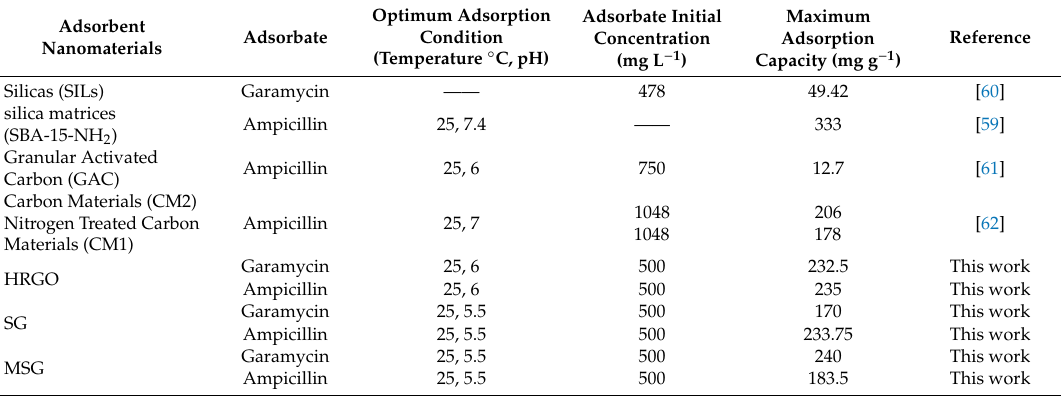
Table 2. A review of the performance of some adsorbent materials used to remove Garamycin and Ampicillin from